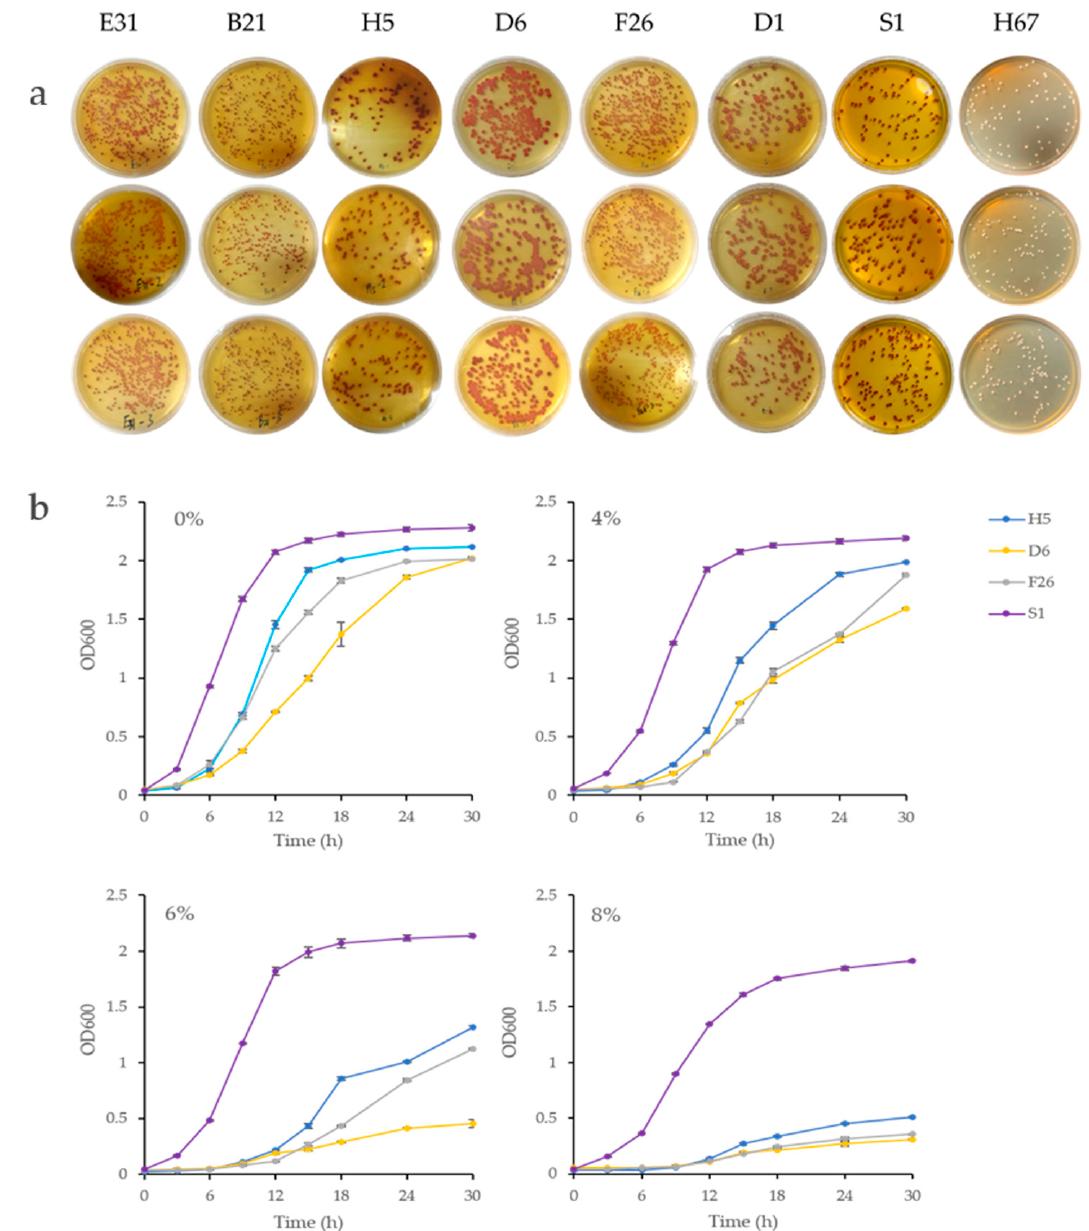
Figure 1. ( a ) The coloration results obtained via the TTC medium chromogenic screening method. The red intensity level of colonies in the culture medium can indirectly reflect the ethanol tolerance of the strains; ( b ) the growth curves of the screened strains at ethanol concentrations of 0%, 4%, 6%, and 8% ( v / v ).